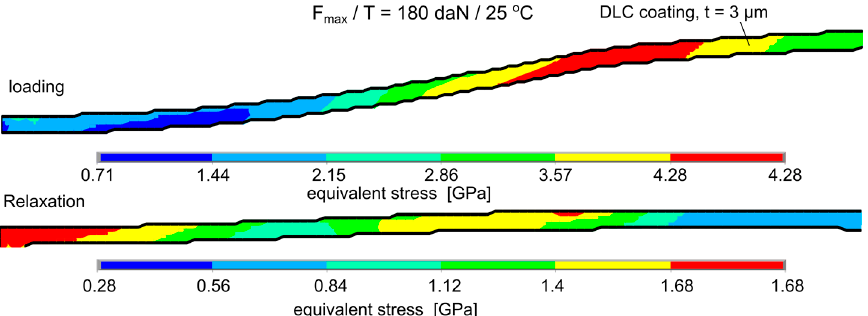
Figure 16. Developed maximum and remaining stress fields in the DLC coating at the fatigue endurance critical force and ambient temperature. Table 1. Maximum equivalent stresses during loading and relaxation at the fatigue endurance critical forces at various temperatures.